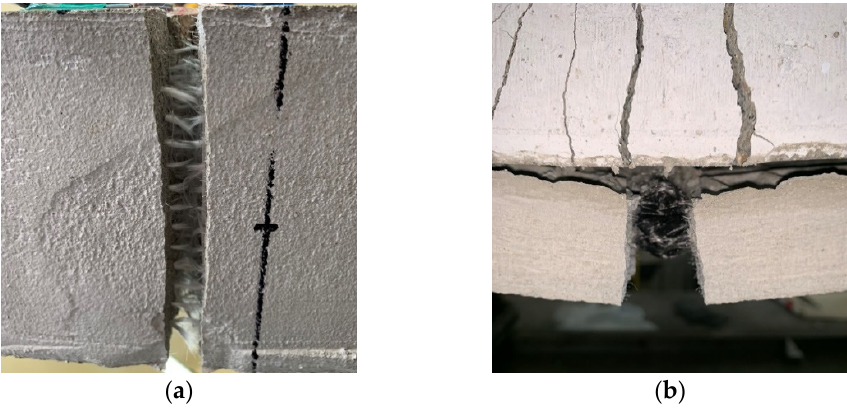
Figure 2. Failure modes: ( a ) Textile rupture; ( b ) IC